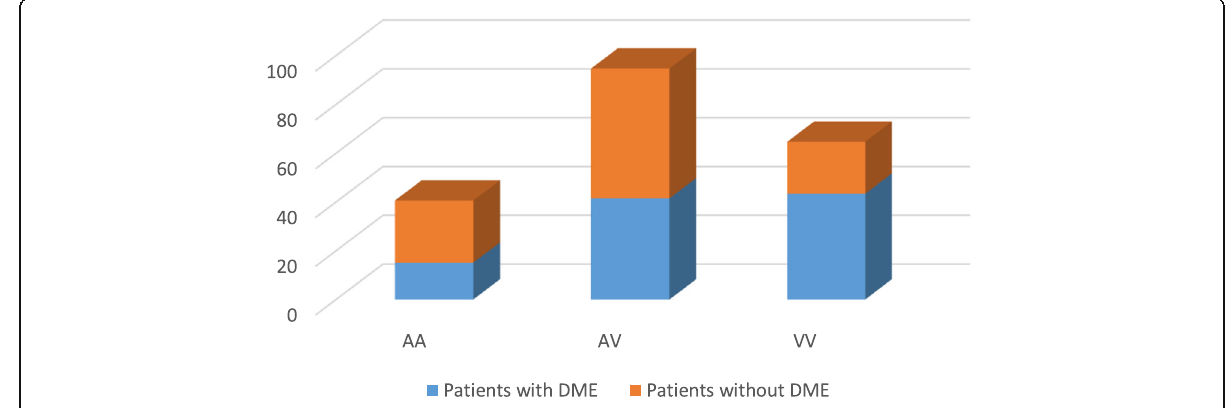
Fig. 1 Frequency distribution of different genotypes in DME and non-DME